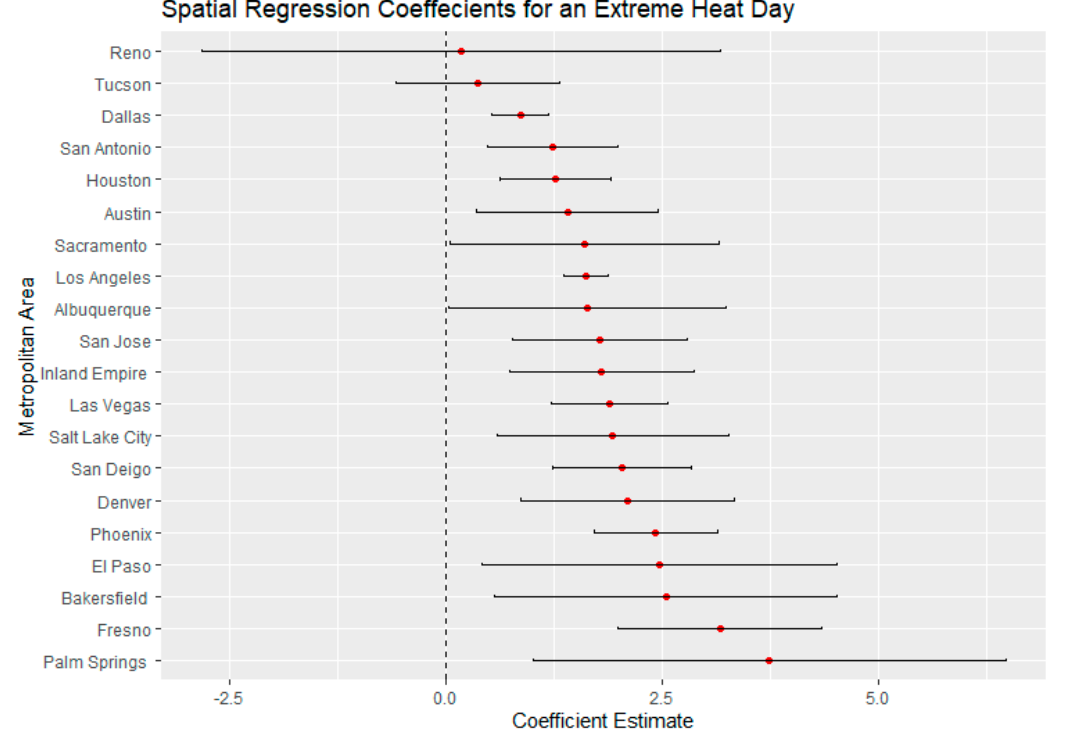
Figure 8. Spatial regression coefficients for Latinx populations during an extreme heat day in 20 Southwest metropolitan areas.